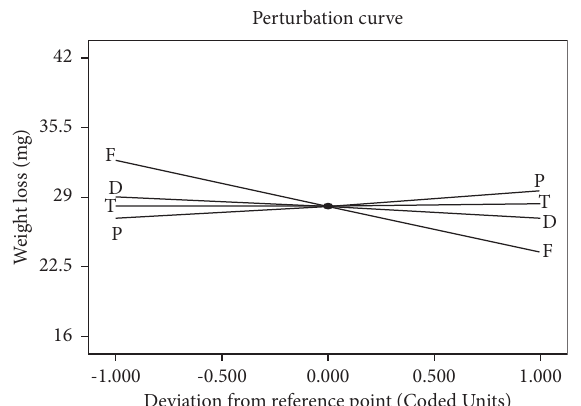
Figure 5: Effect of laser hardfacing processes parameters on weight